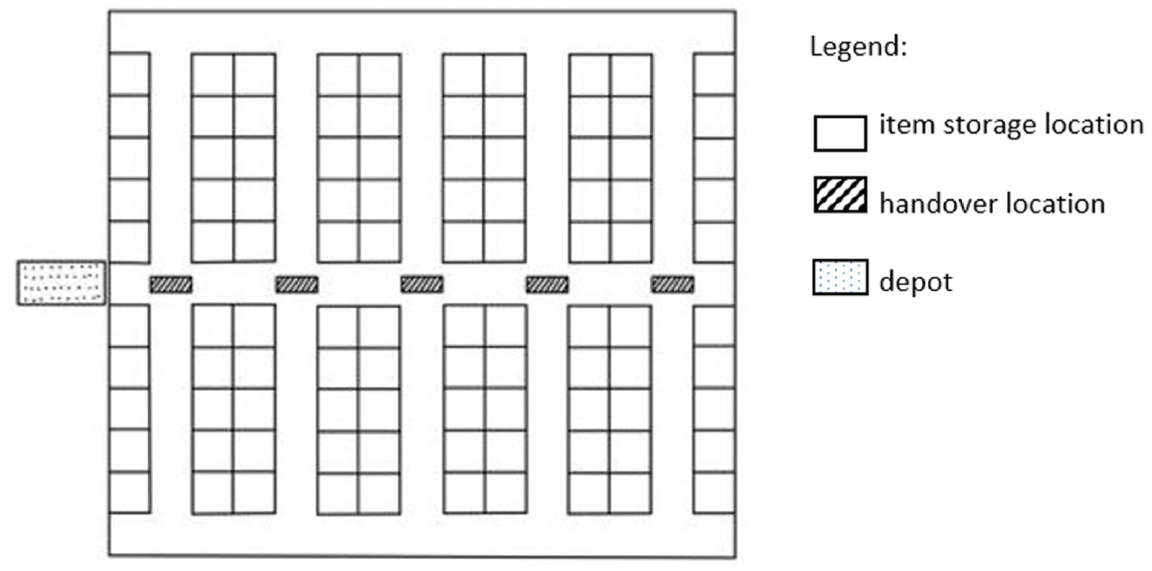
Figure 3. Warehouse with a two-blocks layout and shared handover locations.